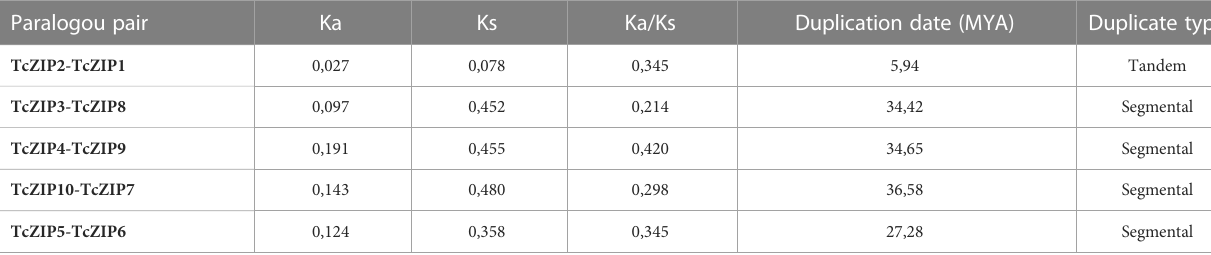
TABLE 2 Ka/Ks analysis and estimated divergence time for ZIP genes pairs in cacao.